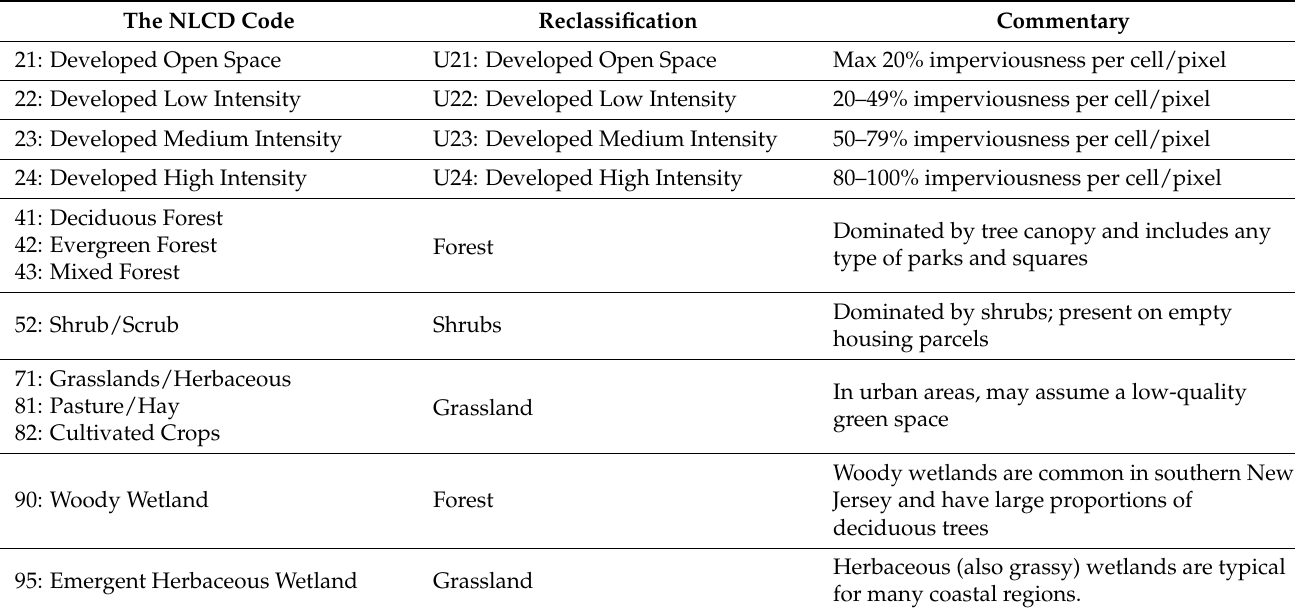
Table 1. Overview of the land cover classes before and after the reclassification of the NLCD dataset.